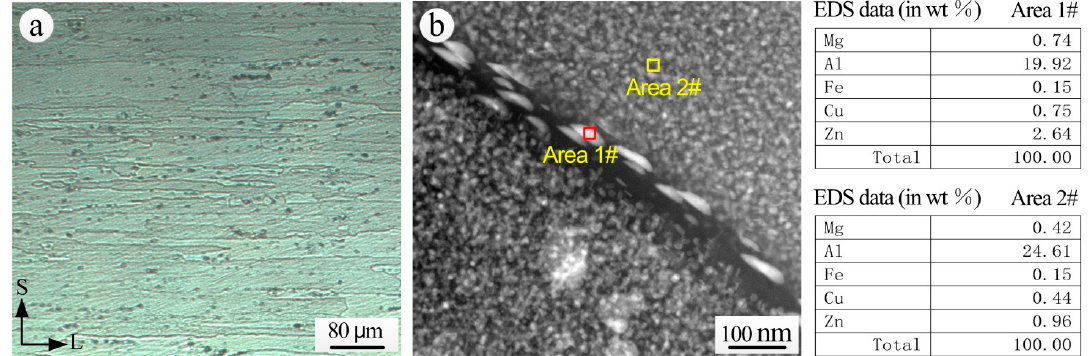
Figure 12. 7075-T6 aluminum alloy ( a ) S-L metallographic section; ( b ) grain boundary structure and EDS analysis taken by TEM.